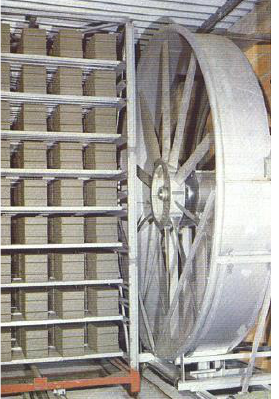
Figure 4. Clay paving blocks in drying chamber.